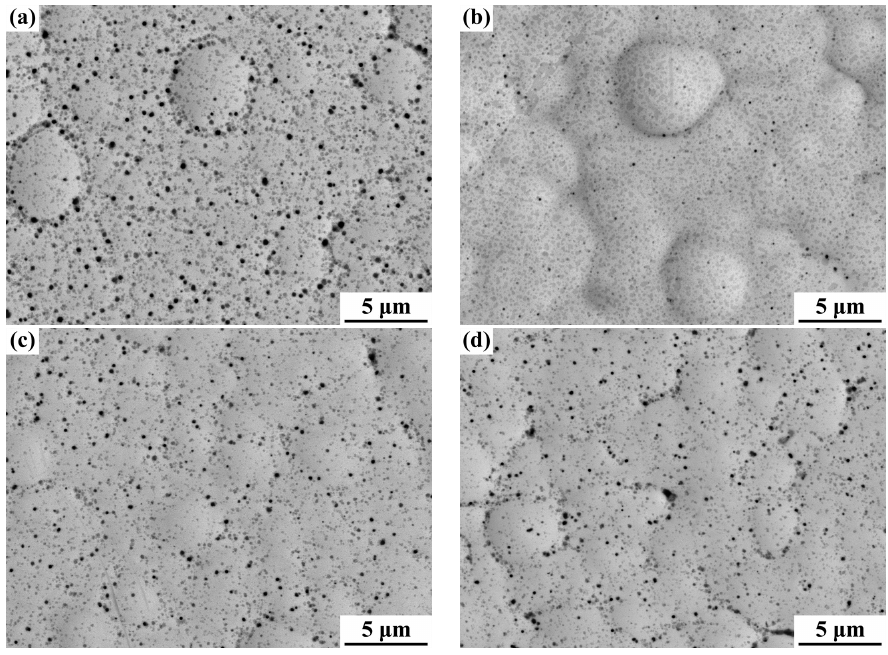
Figure 3. Surface morphologies of Ni ‐ P coatings after electrochemical tests in the four solutions: ( a ) solution A; ( b ) solution B; ( c ) solution C; and ( d ) solution D.